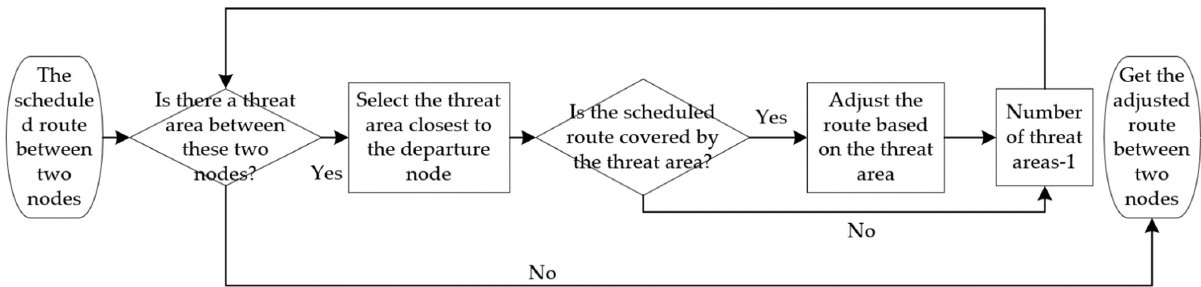
Figure 4. Evasion policy for multiple threat areas.